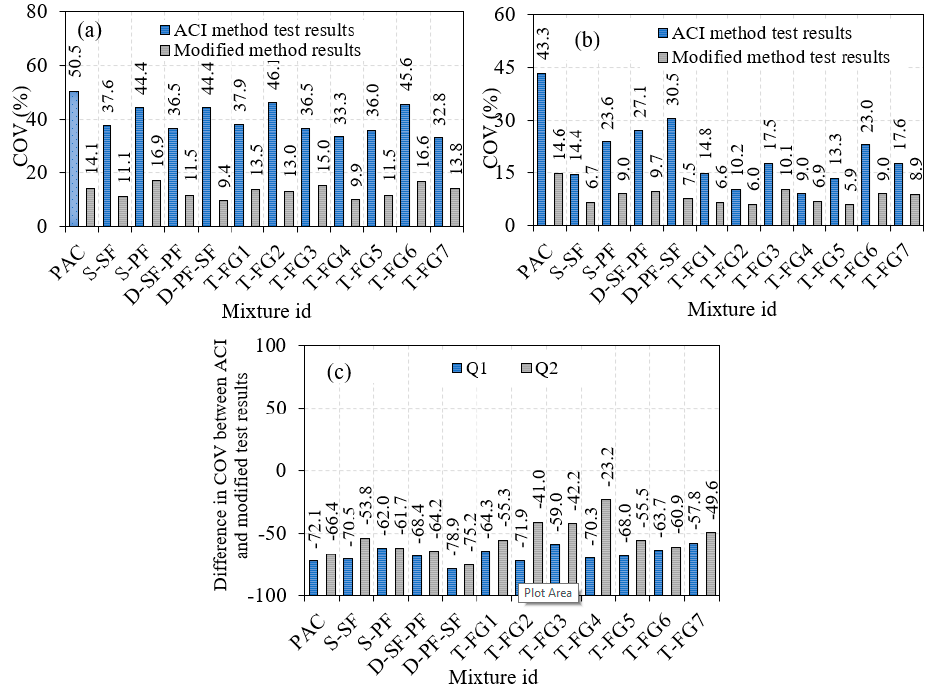
Figure 13. COV comparison ( a ) Q1 ( b ) Q2 and ( c ) Percentage COV difference in two test methods.